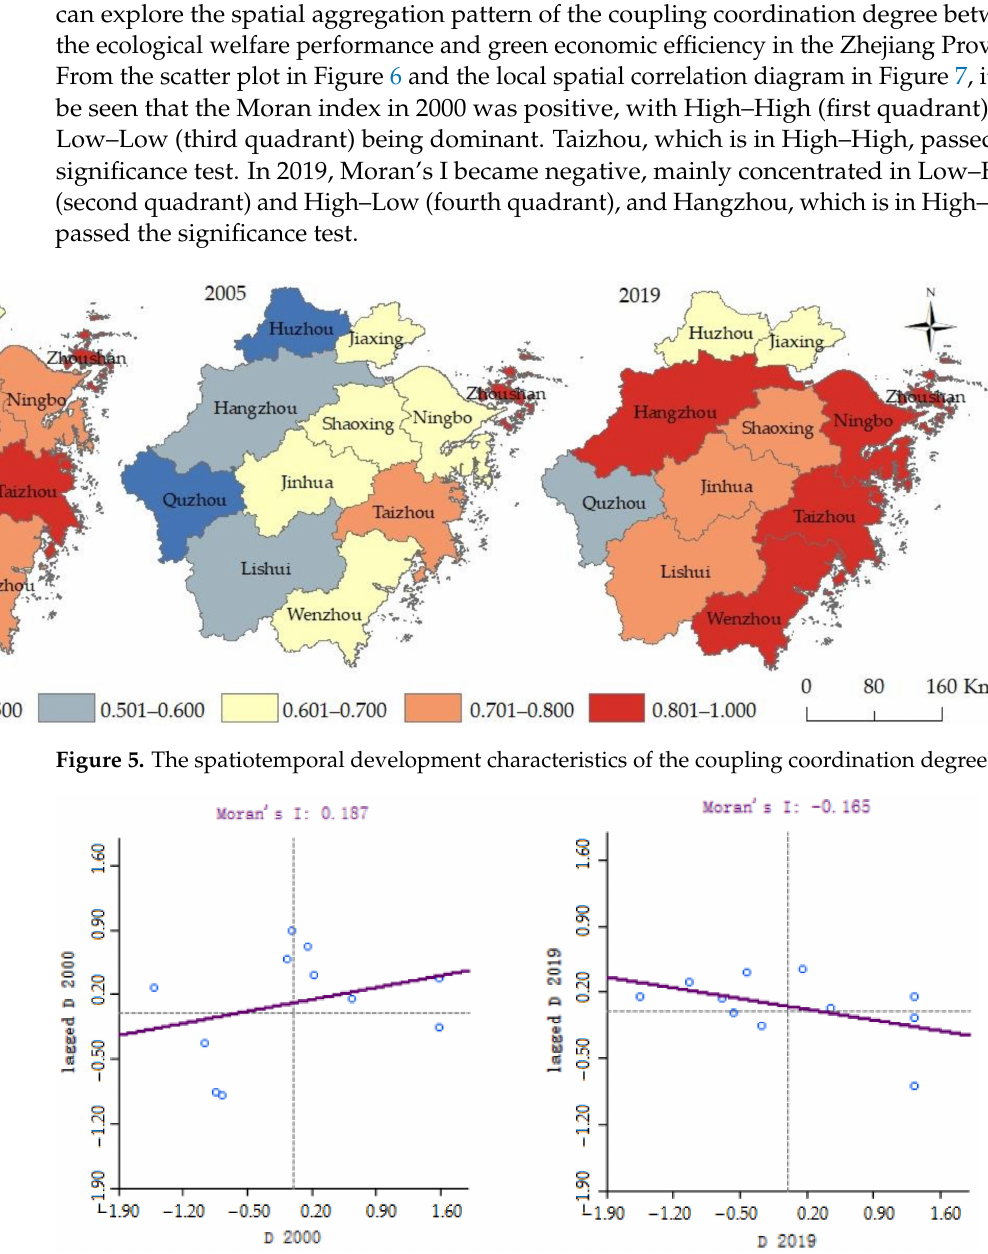
Figure 6. Moran’s I scatter plot for the coupling coordination degree of each city in 2000 and 2019 (the line represents the global Moran’s I index for the year. Each dot represents the location of a sample point. The distance of the dot from the origin in the figure represents the level of aggregation significance, and the farther away from the origin, the better the significance